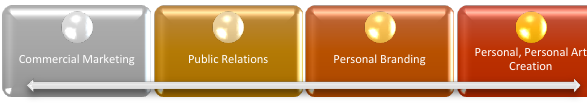
Figure 5. Art Creation